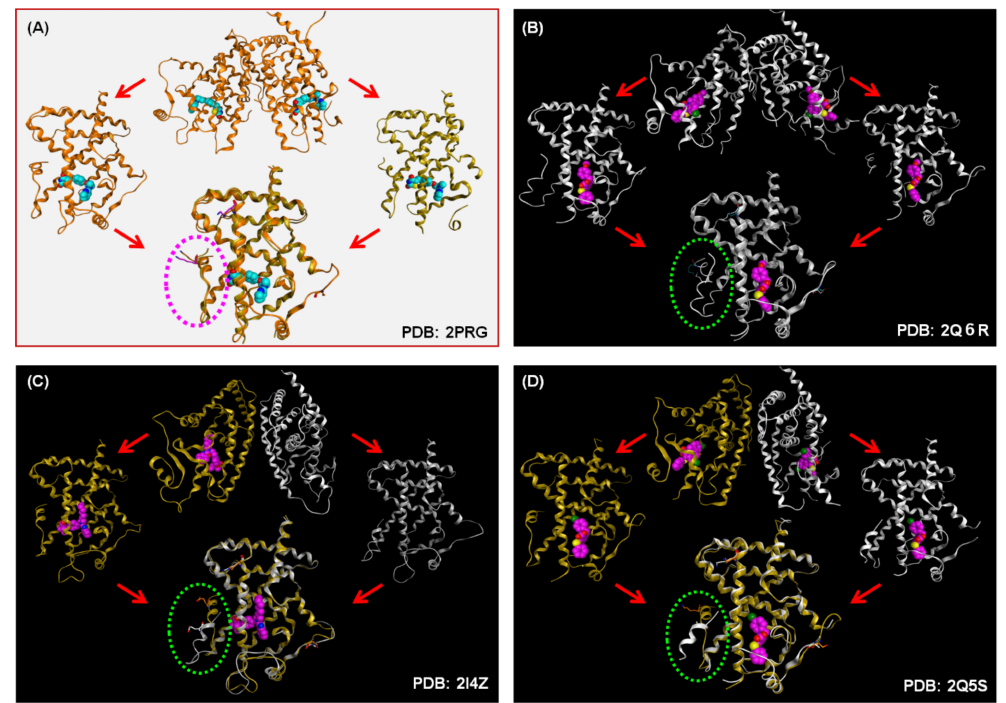
Figure 25. ( A ) X-ray crystallographic structure of homo-dimeric PDB: 2PRG (full agonist). ( B ) X-ray crystallographic structure of homo-dimeric PDB: 2Q6R (partial agonist). ( C ) X-ray crystallographic structure of homo-dimeric PDB: 2I4Z (partial agonist). ( D ) X-ray crystallographic structure of homo-dimeric PDB: 2Q5S (partial